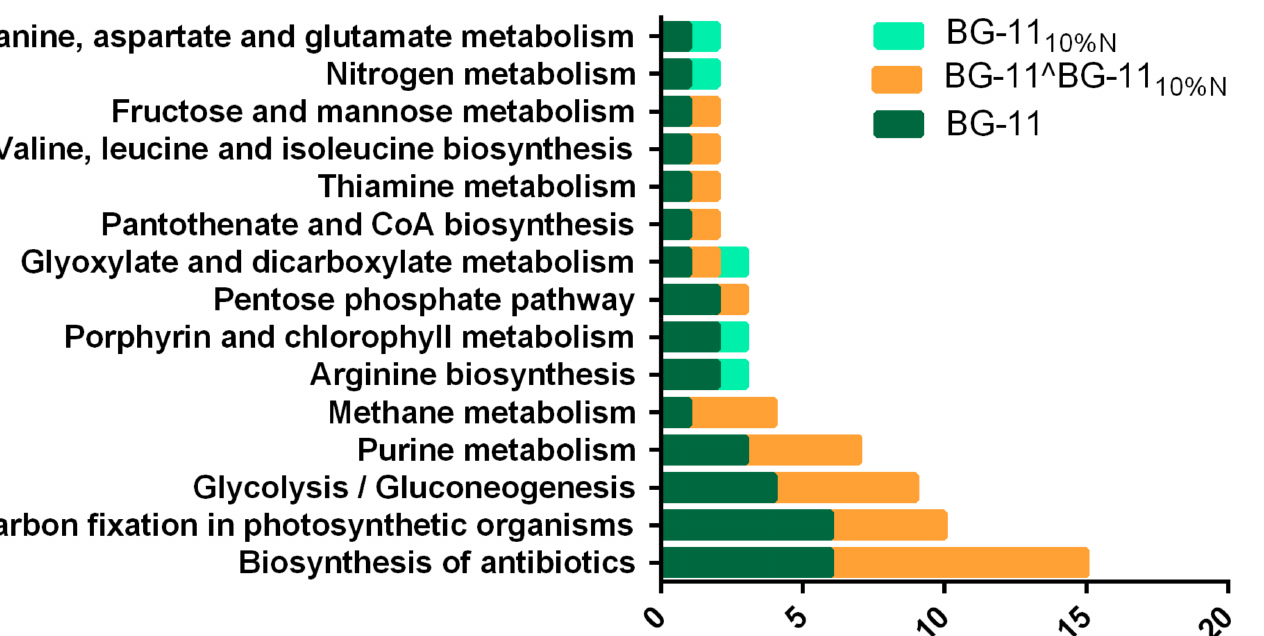
Figure 6. Protein sequences in the two culture media, exclusive and common, attributed to metabolic pathways. According to Blast2GO annotation into KEGG pathways, here are shown pathways with more than one sequence